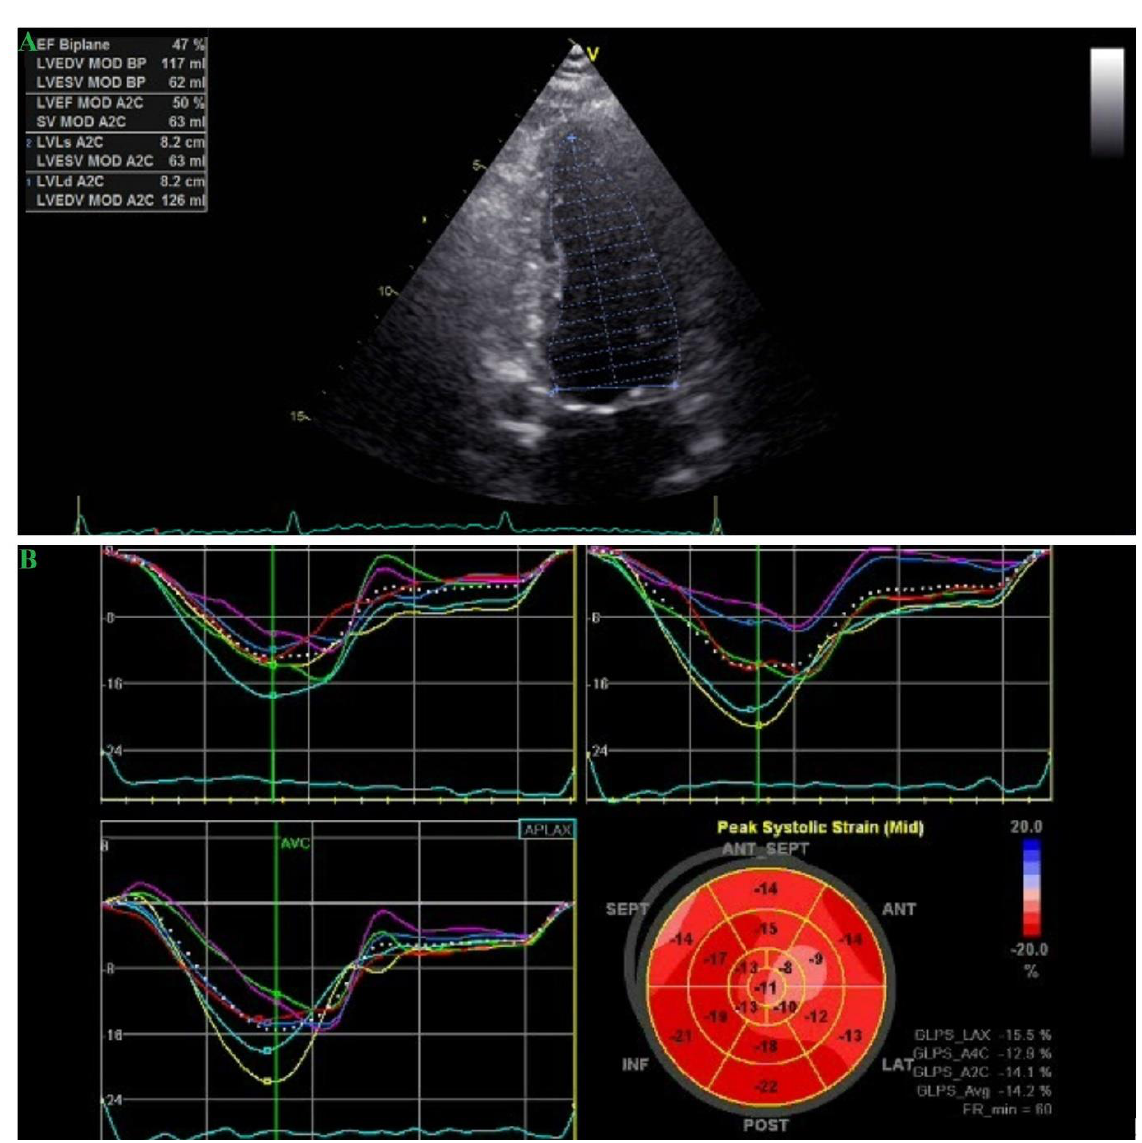
Figure 1. Transthoracic echocardiography: wall motion abnormalities in the left anterior descending artery territory with hypokinesia of the apical segments of the anterior and lateral wall and of the apex; borderline left ventricular systolic dysfunction ( A ) (EF(Ejection fraction) Biplane = 47%); ( B ) reduced peak systolic strain (Mid)—global longitudinal peak strain average (GLPS_Avg) 14.2%.